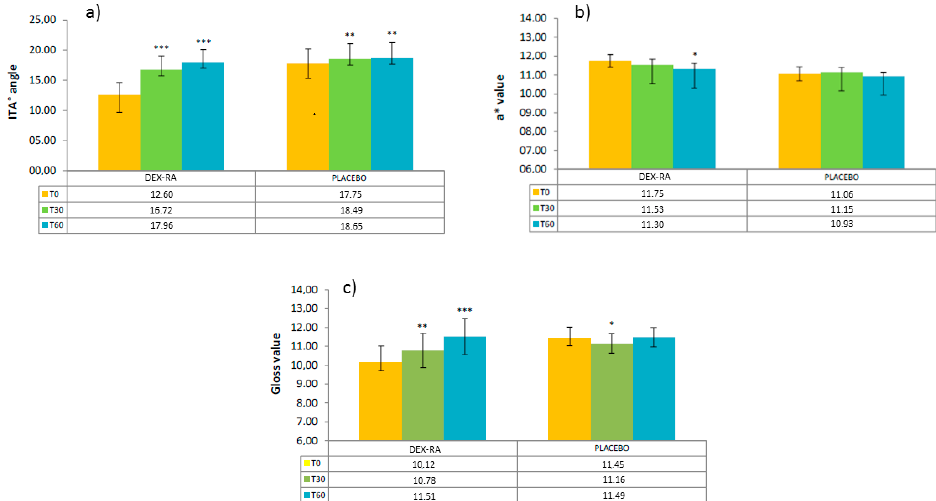
Figure 2. ( a ) ITA° values; ( b ) a* values related to the red component of the skin colour (skin redness) and ( c ) GLOSS values correlated with the ability of the skin to reflect the light (skin radiance/brightness) recorded at each experimental time for each tested formulation. Note: the asterisks above the error bars are referred to the intra-group statistical analysis (vs T0); the inter-group statistical analysis performed by means of t -test for unpaired data is reported in Table 2. Table 2. Inter-group statistical analysis performed by means of t -test for unpaired data. p Values Inter-Group Statistical Analysis T0 T30 T60 DEX-RA VS PLACEBO (INTENSITY OF DARK SPOTS, ITA°) 0.120 0.000 *** 0.000 *** DEX-RA VS PLACEBO (RED COMPONENT OF THE SKIN COLOR, a*) 0.055 0.059 0.186 DEX-RA VS PLACEBO (GLOSS PARAMETER) 0.231 0.000 *** 0.000 *** Legend: ***, p < 0.001; **, p < 0.01; *, p < 0.05. Low ITA° values are ascribable to a brown pigmentation, while high ITA° values indicate a very light pigmentation; therefore, in this study, it is desirable to record an increase of ITA° that indicates a reduction of the dark spot intensity. After 30 and 60 days of use, the efficacy of the tested formulation with DEX-RA in reducing the dark spot staining and in increasing the skin radiance resulted greater, in a statistically significant way, than the efficacy of the PLACEBO formulation at each experimental time. Furthermore, the formulation with DEX-RA determined a reduction of the skin redness statistically significant compared to T0. Figure 3 reports the percentage of subjects who showed/did not show an improvement after 30 and 60 days of products use in terms of reduction of dark spots appearance and skin complexion brightness.